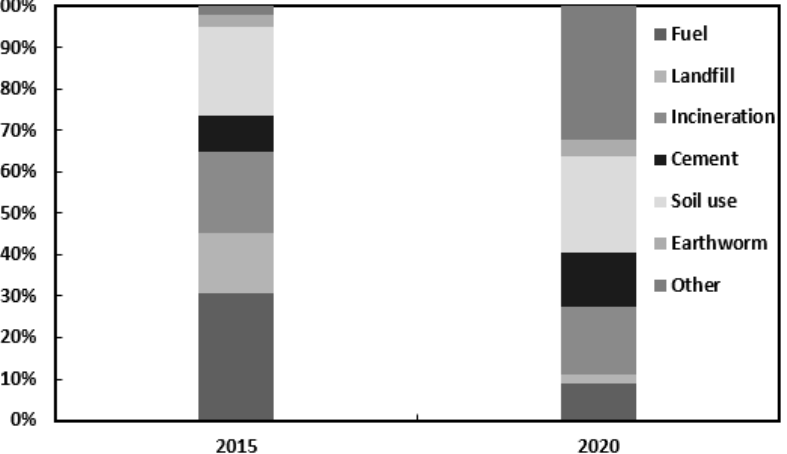
Figure 4. Changes in main sewage sludge treatment methods. The bar graph means the ratio of sewage sludge by treatment method.